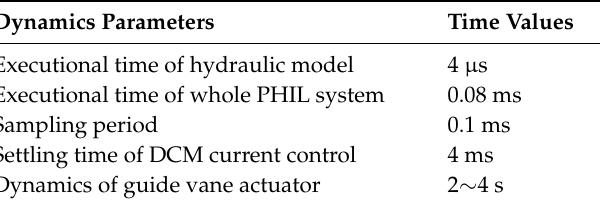
Table 3. Key parameters regarding dynamics.